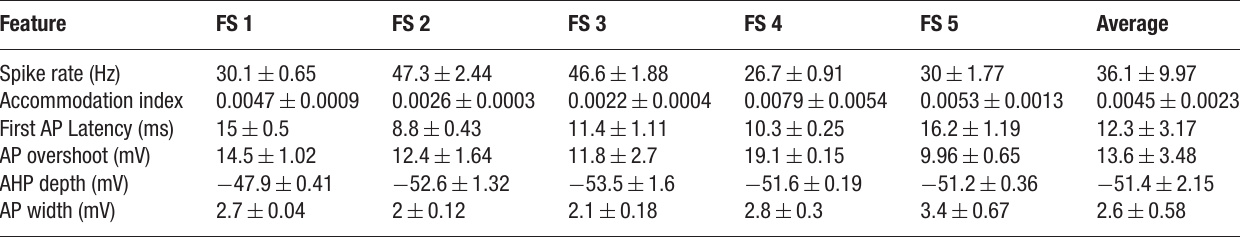
Table 3 . Feature statistics for five fast spiking interneurons (current input,